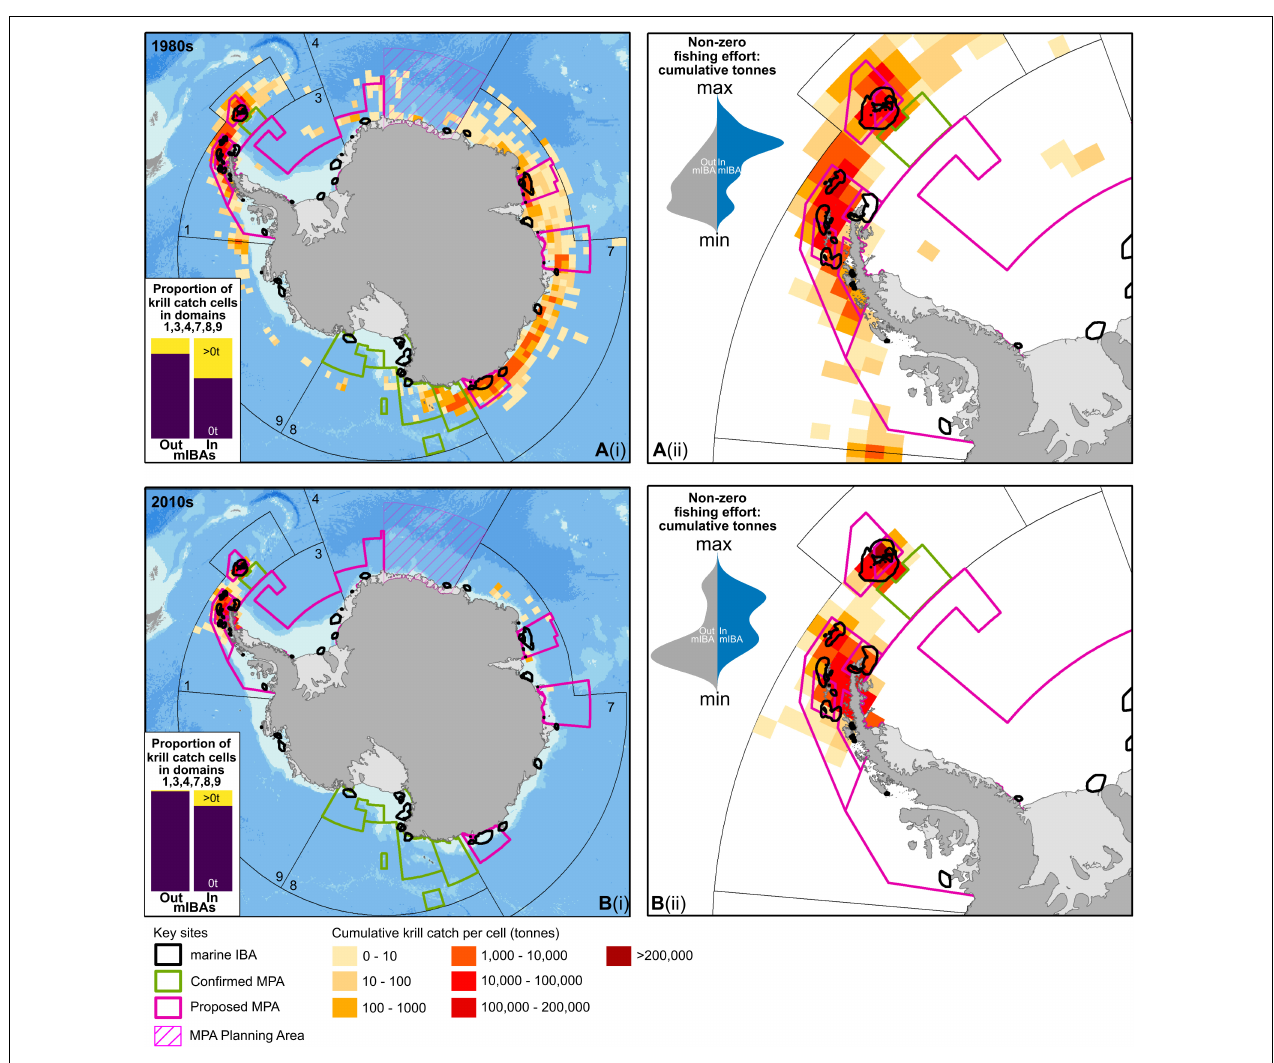
FIGURE 3 | Summer krill fishing effort (Oct – Mar) for past ( A: 1980) and current decades ( B: 2010) across the study area; MPA planning domains contiguous to mainland Antarctica (Domains: 1, 3, 4, 7, 8, and 9). Fishing effort recorded as cumulative krill biomass caught per cell (tonnes). Panels i, indicate continent wide fishing effort across relevant domains, while panels ii, indicate fishing effort for the Antarctic Peninsula. Inset in panels i, indicates proportions of cells inside and outside marine IBAs in which krill was caught ( > 0t, yellow) or not caught (0t, purple). Inset in panels ii (kernel density plots), show the distribution of cumulative krill biomass caught per cell (zero values not shown) inside (blue) versus outside (gray) marine IBAs. The scale for kernel density plots ranges between the minimum and maximum krill biomass caught per cell in a given decade. For all decades, see Supplementary Appendix : Overlap of krill fisheries with marine IBAs.